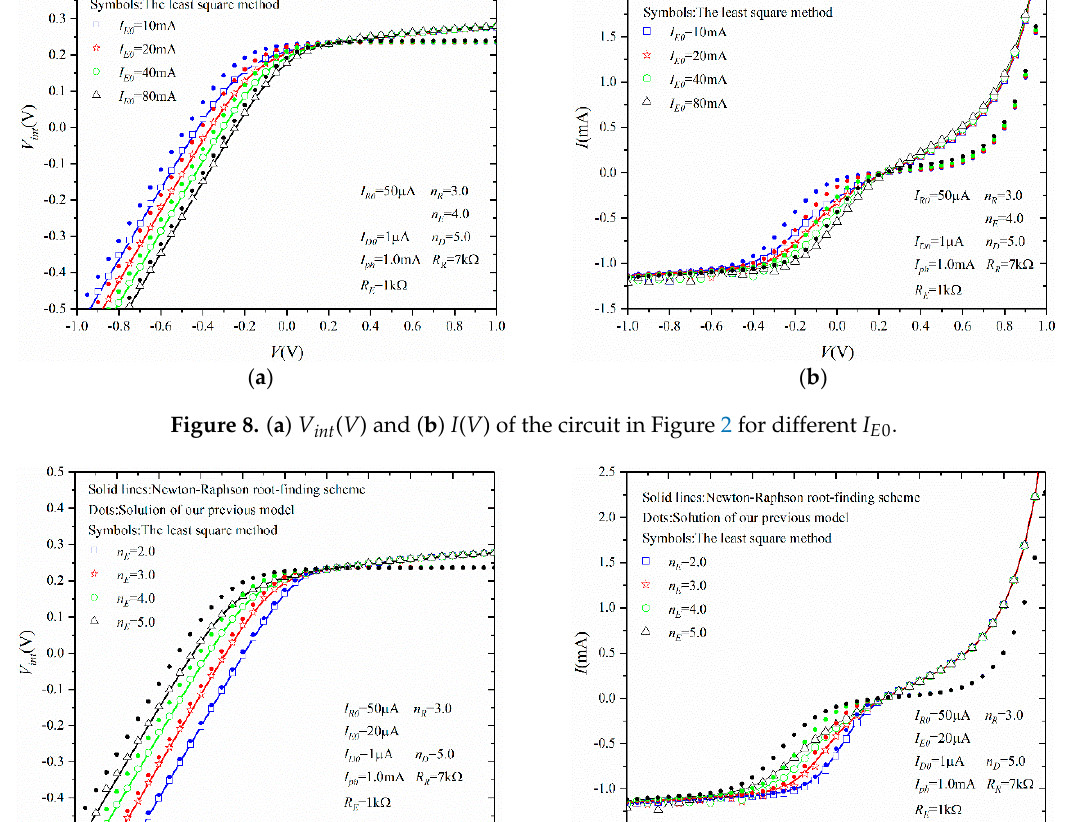
Figure 7. ( a ) V int ( V ) and ( b ) I ( V ) of the circuit in Figure 2 for different n R .